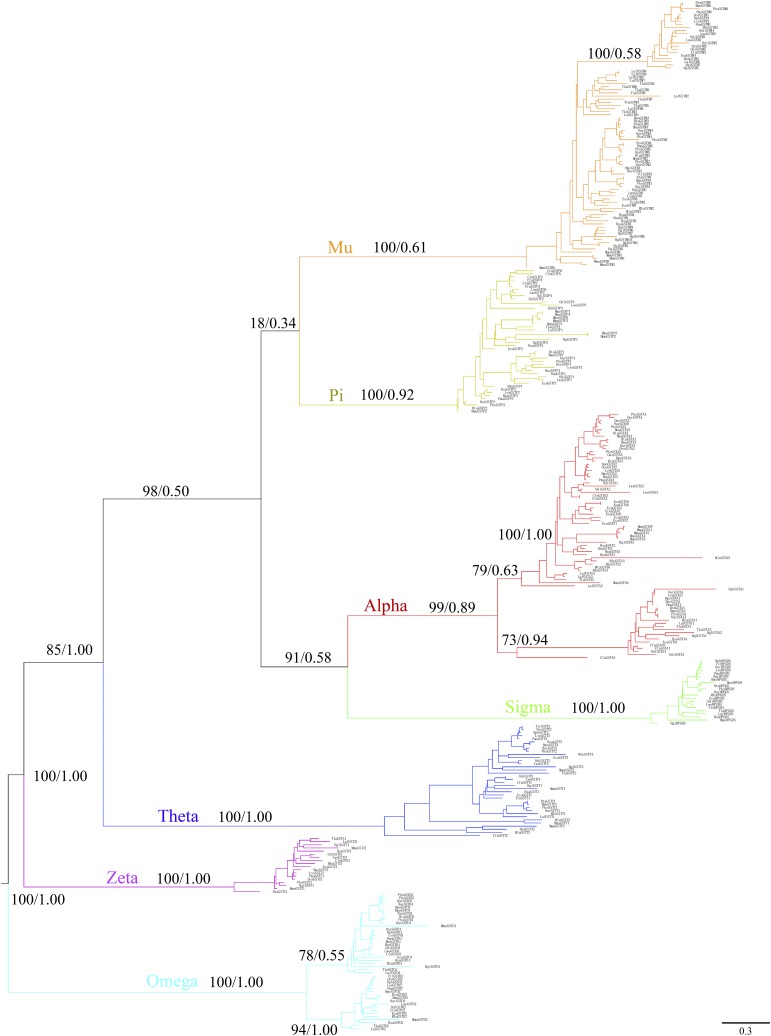
Phylogenetic tree of GST gene family in mammals. Maximum likelihood and Bayesian phylograms describing phylogenetic relationships among 333 intact (complete coding sequences) mammalian GSTs (21 species). Numbers on nodes correspond to maximum likelihood bootstrap support values and Bayesian posterior probabilities. The GST subclasses are indicated by different colors: alpha (red), mu (orange), pi (turquoise), omega (azure), sigma (green), zeta (purple), and theta (blue).